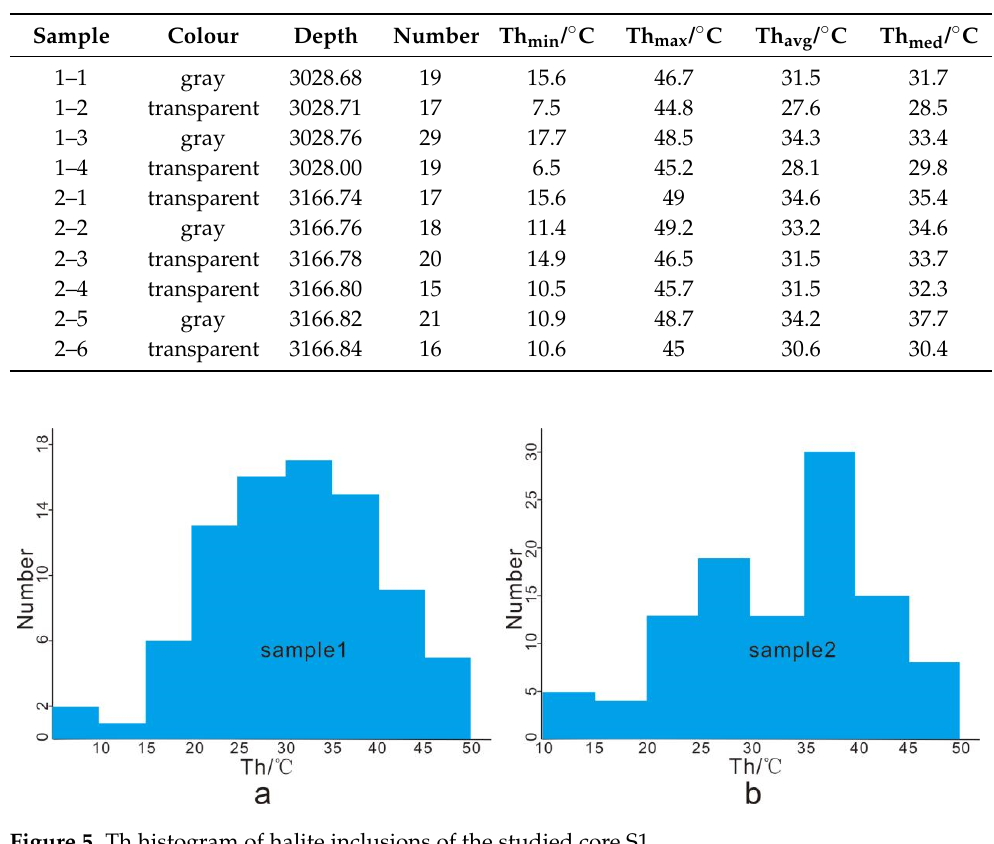
Table 3. Ion contents of halite fluid inclusions from sample 1.